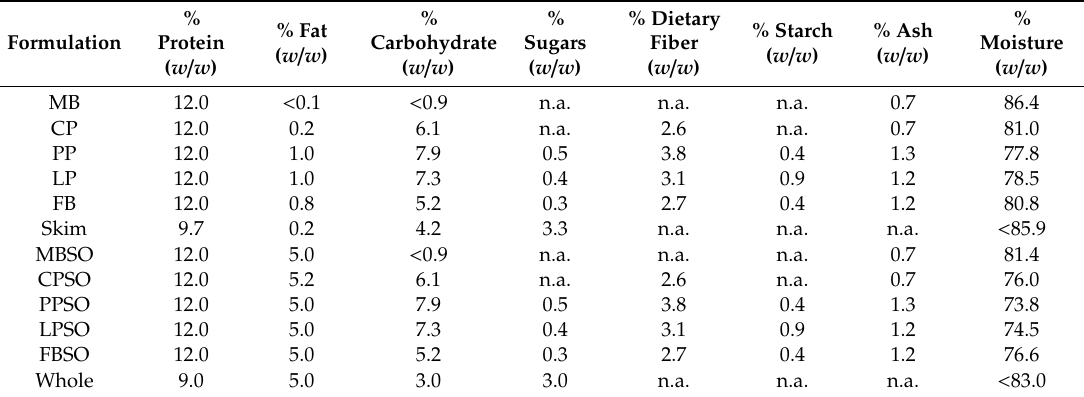
Table 1. The composition of 12% ( w / w ) protein solutions of mung bean (MB), chickpea (CP), pea (PP), lentil (LP) and faba bean (FB) without and with 5% ( w / w ) sunflower oil (SO), and reference plain skim and whole milk Greek yogurts from data provided by the manufacturers and tabulated using Microsoft